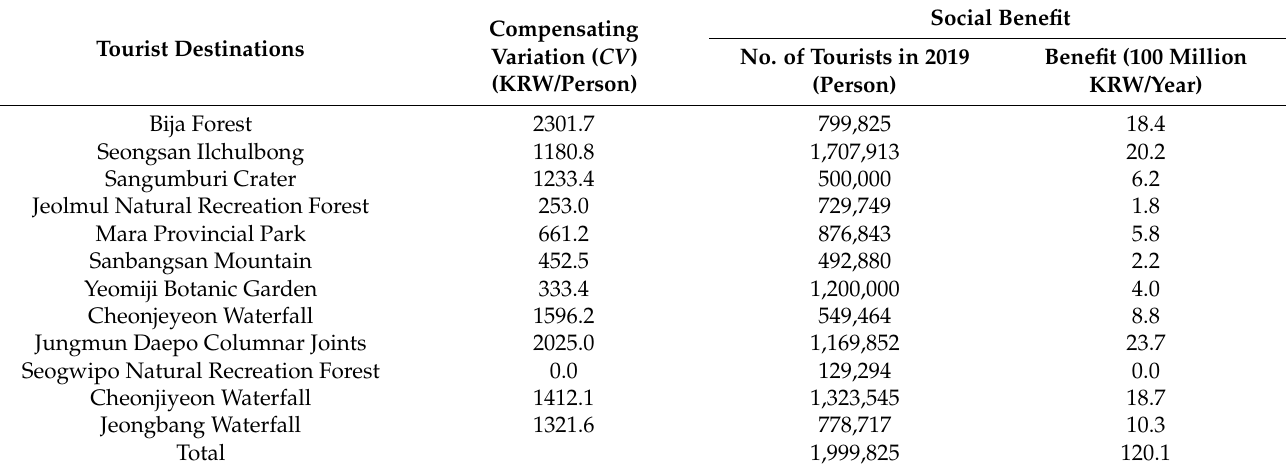
Table 7. Results of the benefit